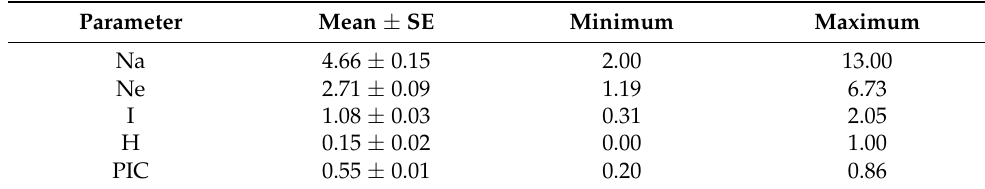
Table 1. Genetic diversity parameters of rice landraces in the Honghe Hani terraces based on SSR markers.